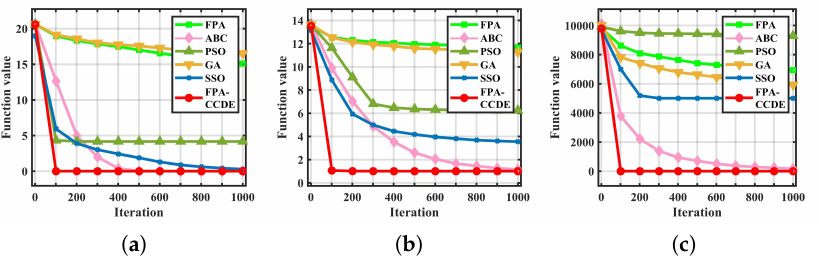
Figure 3. Fitness value graphs of benchmark functions: ( a ) the fitness value of F21; ( b ) the fitness value of F24; ( c ) the fitness value of